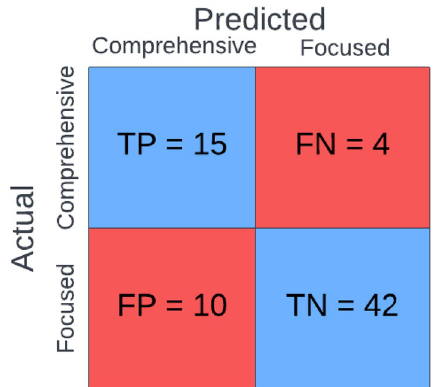
Fig. 5 Confusion matrix providing a visual representation of the machine learning prediction model’s output for the hold-out test dataset. Out of the 71 patients in the hold-out test dataset, the ML prediction model successfully classified 57 patients as requiring comprehensive ABA treatment or focused ABA treatment. ABA applied behavioral analysis; TP true positive; FP false positive; TN true negative; FN false